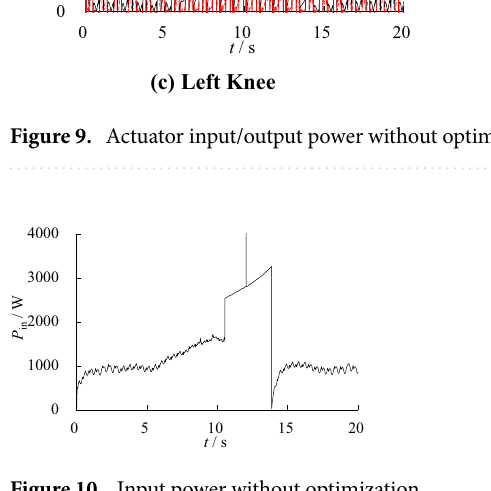
Figure 10. Input power without